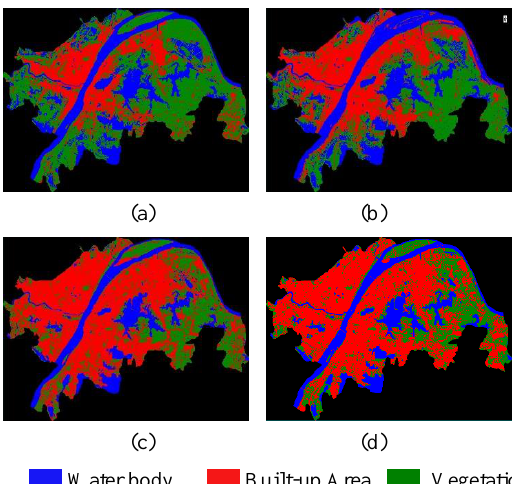
Figure 8. The classification results of multi-temporal images: (a) 1991, (b) 2002, (c) 2011, and (d) 2017.